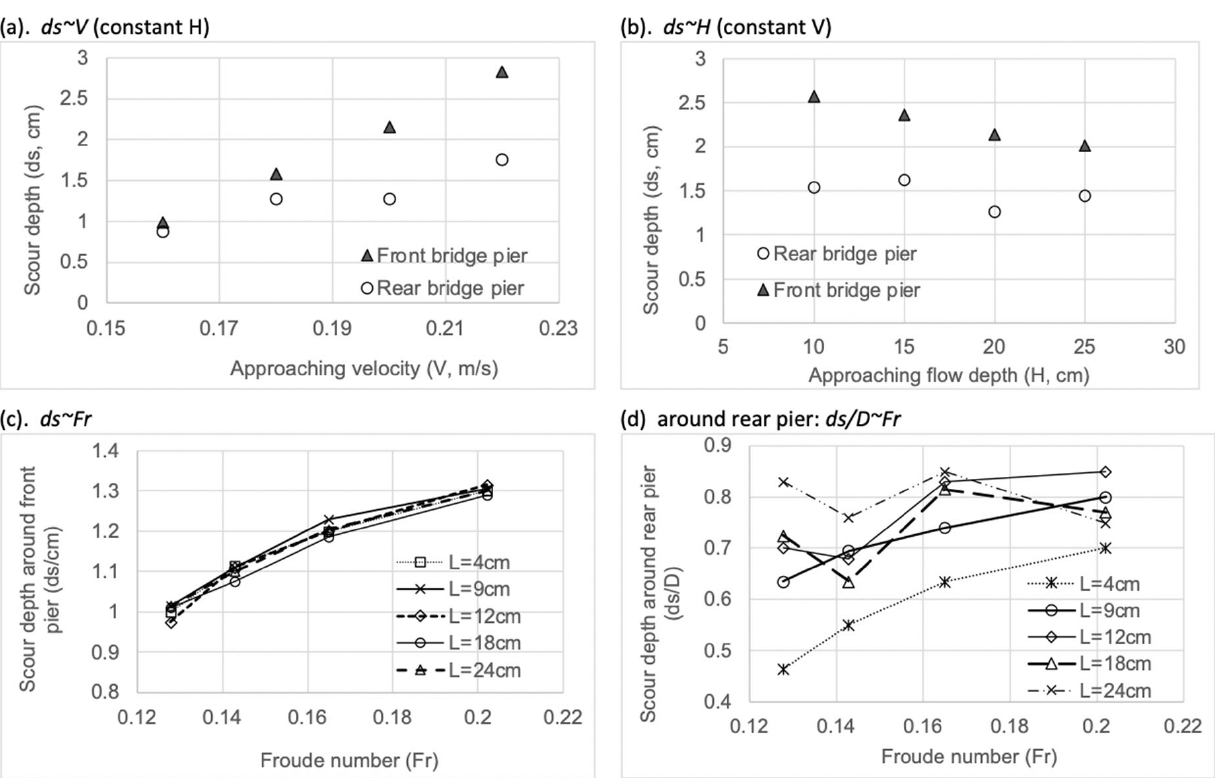
Figure 11. Relationship between scour depth ( ds , or d S /D) and hydraulic conditions ( V, H , or Fr ).